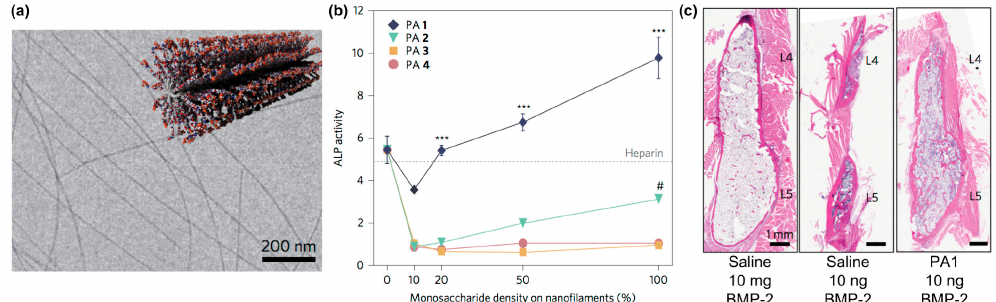
Figure 7. Sulfated glycopeptide amphiphile nanofilaments amplify BMP-2 activity. ( a ) Representative cryo-TEM image of self-assembled sulfated glycopeptide amphiphile nanofilaments formed in aqueous solution. The inset shows a cartoon representation of the self-assembled sulfated glycopeptide amphiphile nanofilament structure. ( b ) Alkaline phosphatase (ALP) activity in C2C12 cells treated with BMP-2 and glycopeptide amphiphile nanofilaments increased with increasing monosaccharide density; results from heparin control group (10 µ g · mL − 1 ) are shown by the dashed line. It can be observed that the self-assembled trisulfated glycopeptide amphiphile nanofilaments (PA1) significantly increased the e ff ect of BMP-2 on ALP activity. Two-way analysis of variance (ANOVA) with Bonferroni post hoc test, *** p < 0.001 compared with PAs 2–4, # p < 0.05 compared with PAs 3 and 4; ( c ) Representative hematoxylin and eosin (H&E) staining of sagittal cross-sectional images of bilateral fusion between L4 and L5 transverse processes. A comparable fusion was observed using PA1 and BMP-2 at 100-fold lower concentration. PA1: trisulfated 3,4,6S- N -acetyl glucosamine modified peptide amphiphile nanofilaments; PA2: monosulfated 6S-GlcNAc modified peptide amphiphile nanofilaments; PA3: monocarboxylated glucuronic acid-modified peptide amphiphile nanofilaments; PA4: peptide